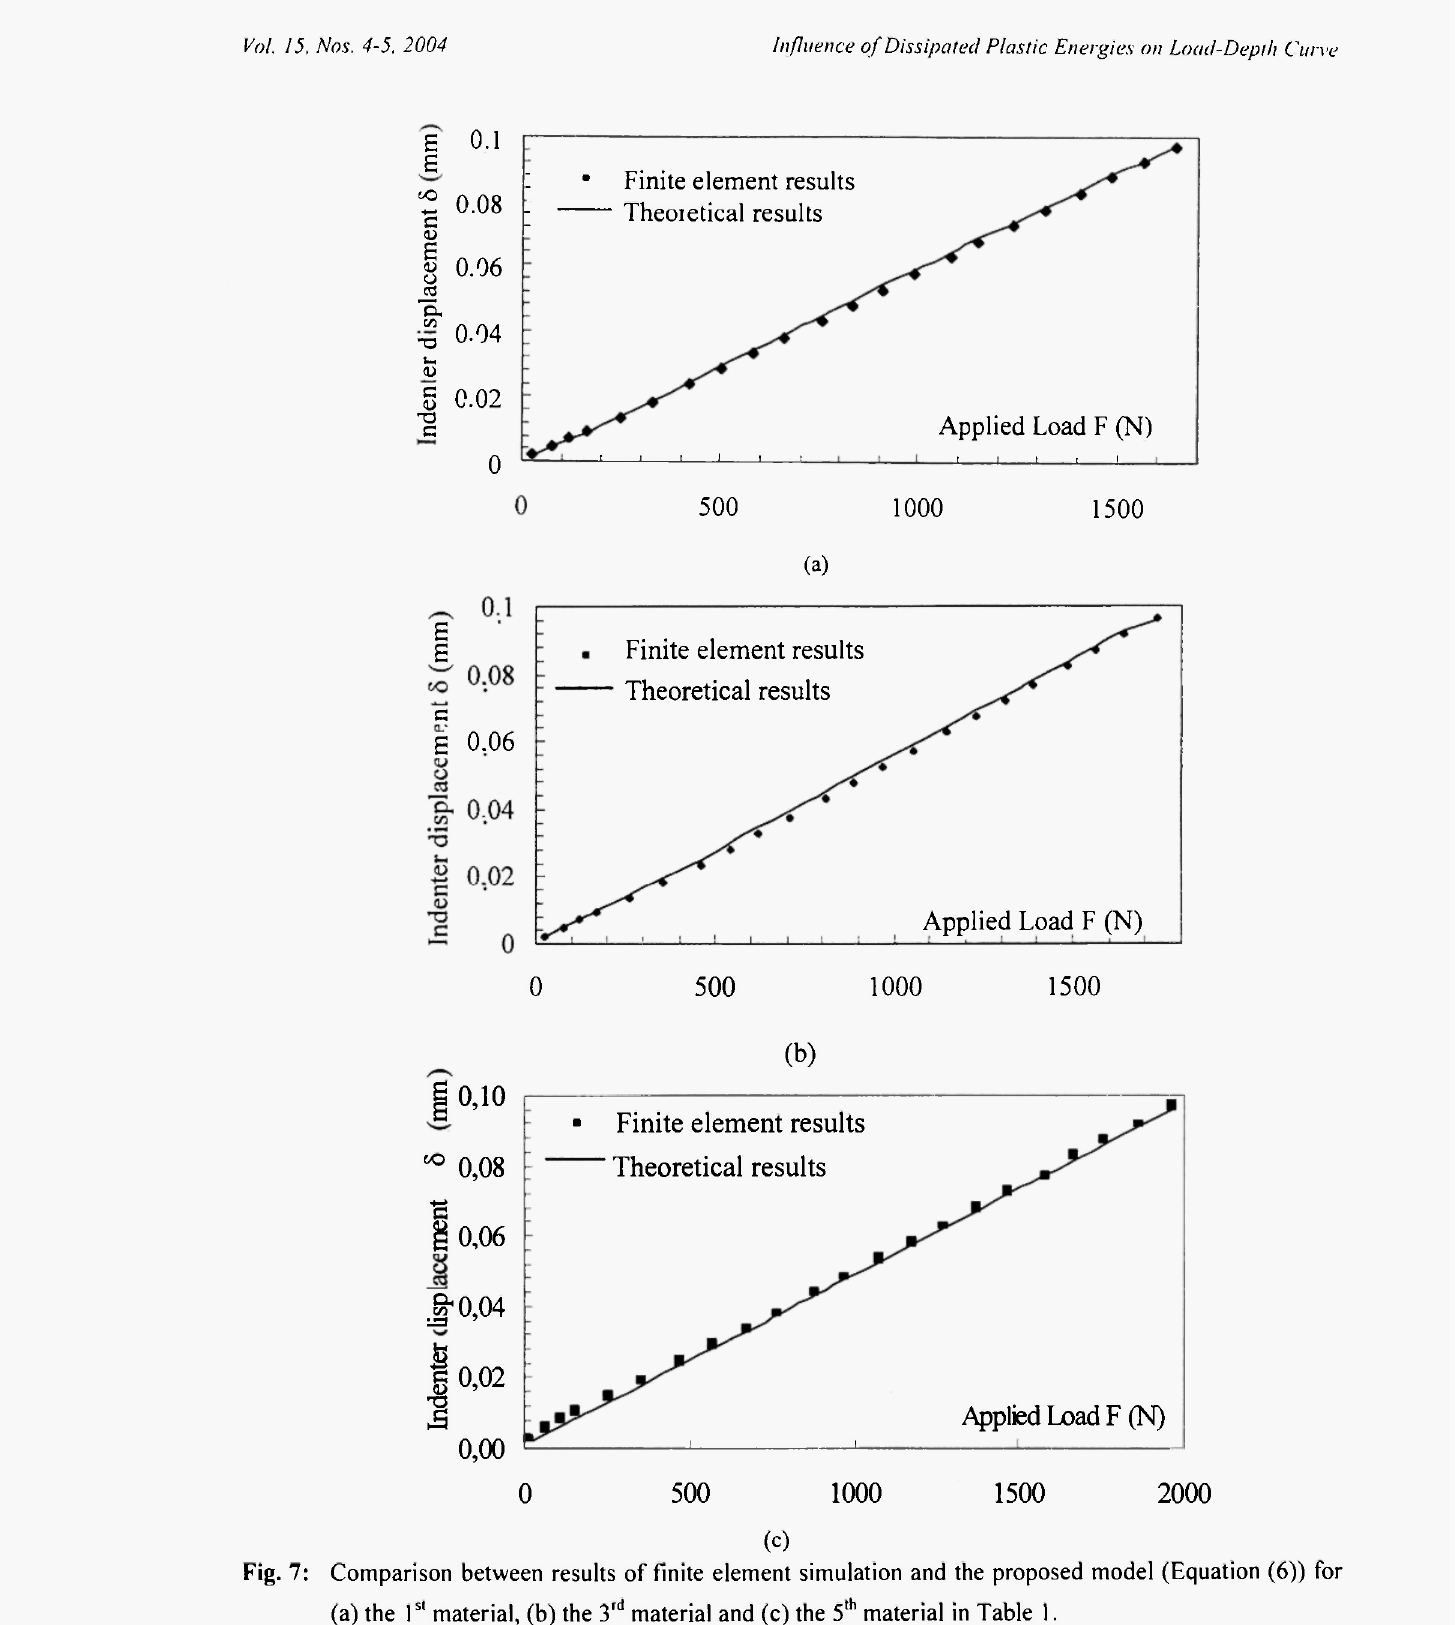
Fig. 7: Comparison between results of finite element simulation and the proposed model (Equation (6)) for (a) the I s ' material, (b) the 3 rd material and (c) the 5 th material in Table